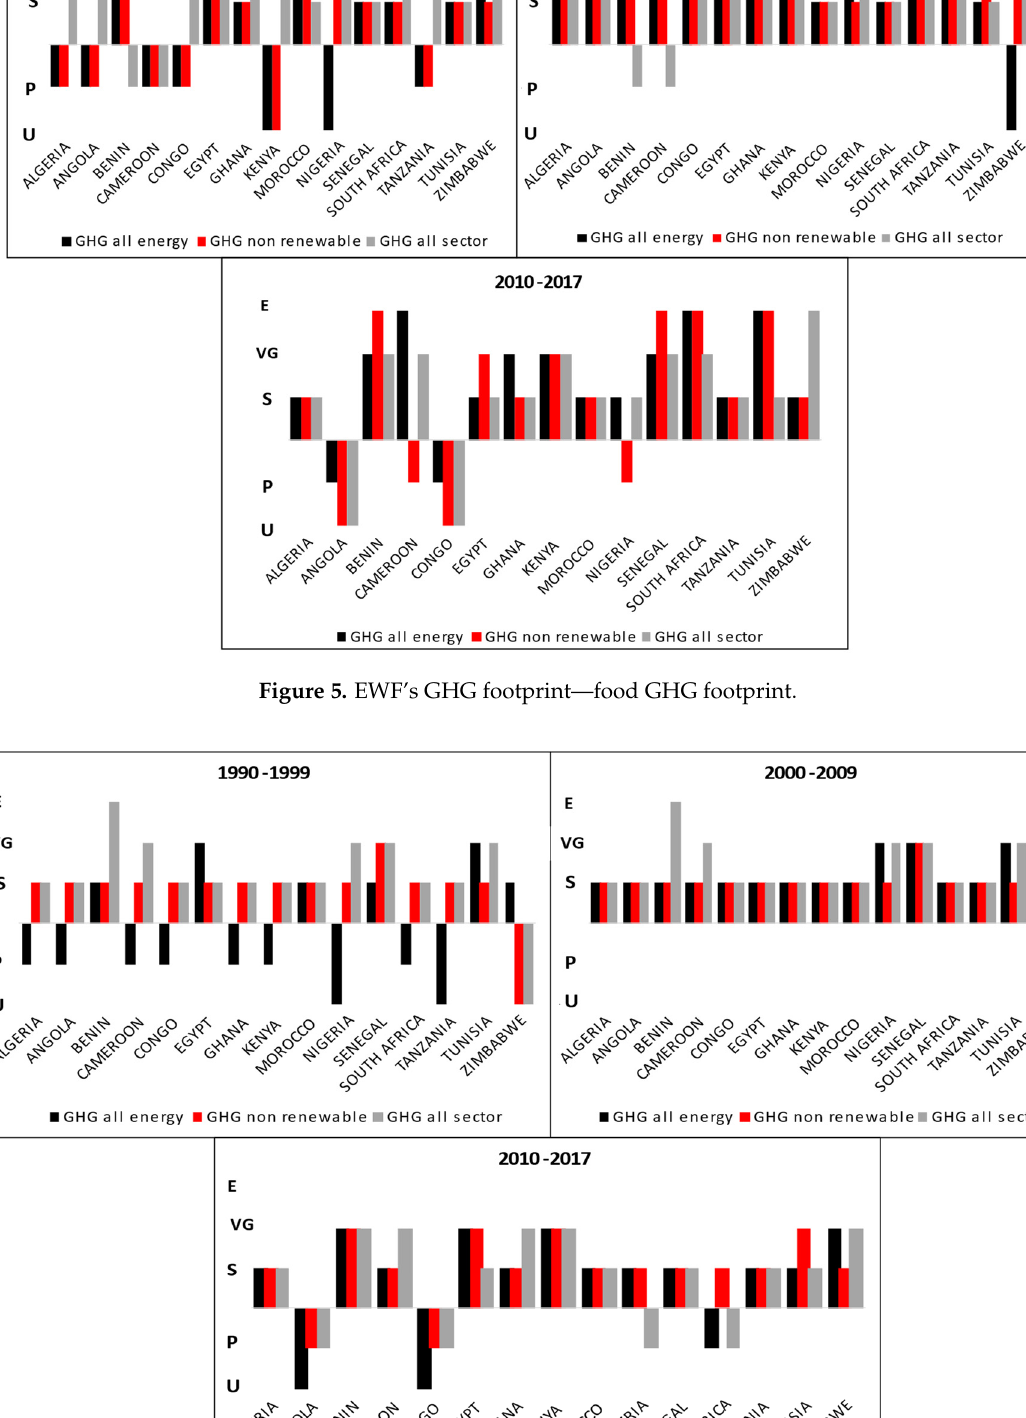
Figure 6. WEF’s GHG footprint–non-renewable energy’s GHG footprint.